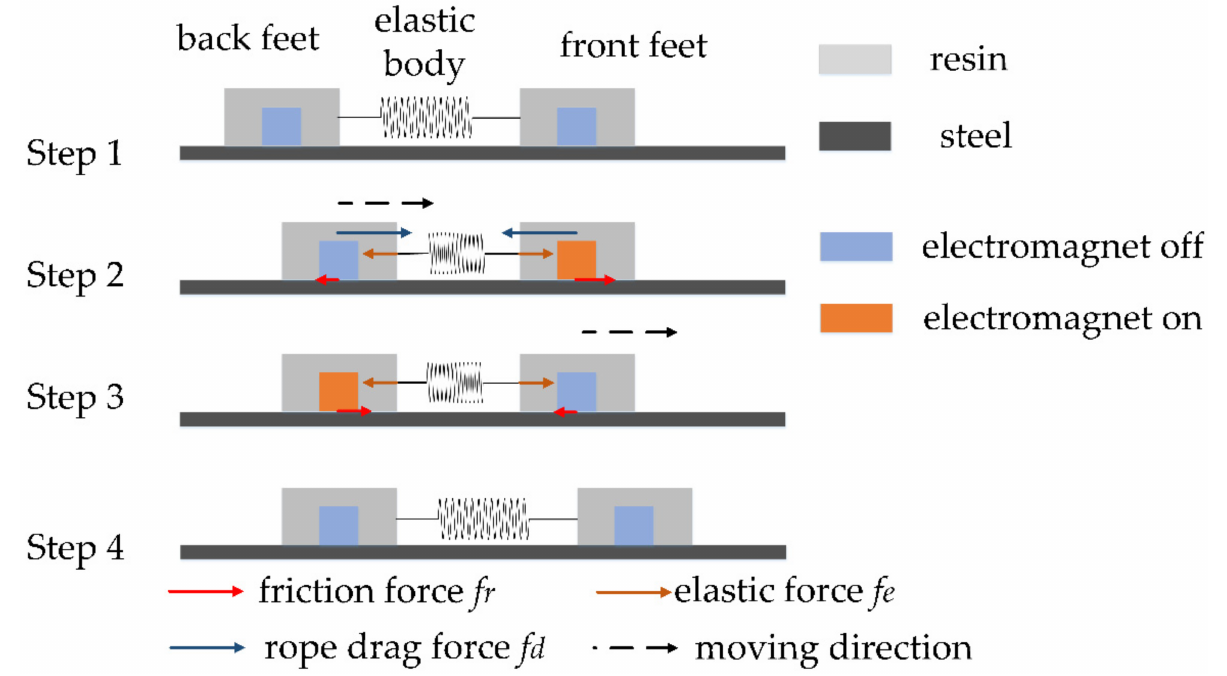
Figure 22. Schematic view of the friction force and moving status of electromagnetic sliding feet with forward motion in one